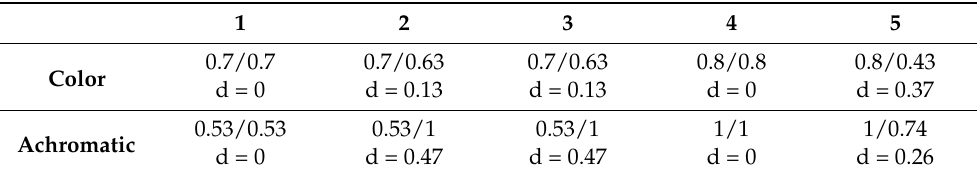
Table 2. Michelson contrast ratios ( C ) of each shape in a pair as a function of the hue condition and local variability/complexity (from 1 to 5 as shown in Figure